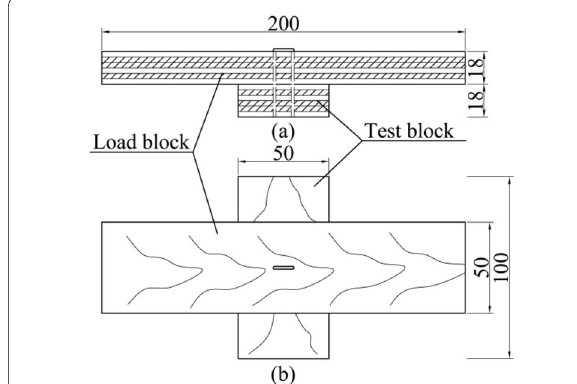
Fig. 4 The general configuration of a load-test block connection used for evaluating the direct withdrawal load of a single staple from a tested plywood block a front view, b top view (unit: mm)